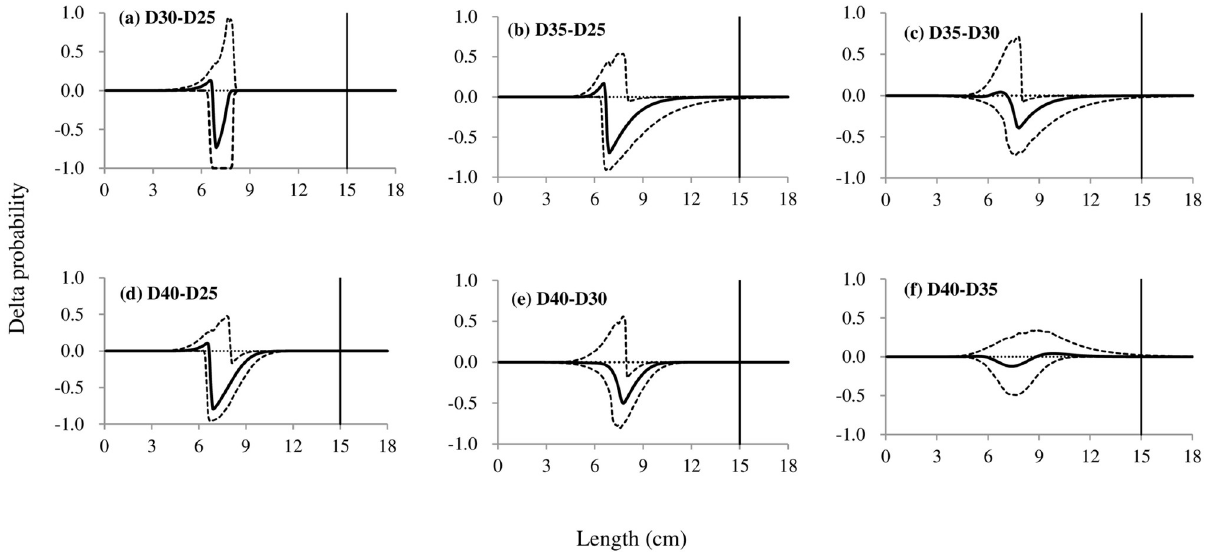
Fig 4. Delta selectivity curves from comparisons of four codends, the D25, D30, D35 and D40 codend. The solid black curves represent the differences of selectivity for each comparison, and the stippled curves represent the 95% confidence intervals. Vertical lines represent the MLS (minimum landing